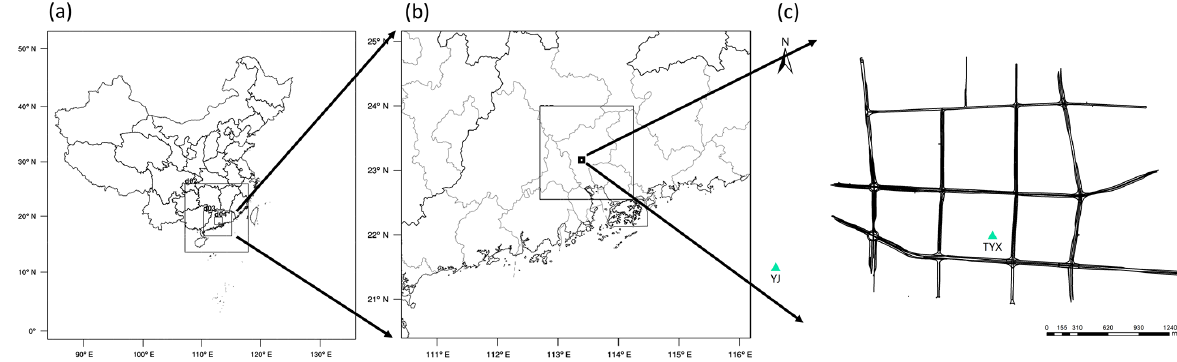
Figure 7. Simulation domain from regional scale to street-level scale: (a) four times nested simulation for WRF; (b) domains 3 and 4 covering the Pearl River Delta region and Guangzhou city, the innermost box corresponds to the Tianhe District; (c) 31 street segments and two observation sites (triangles) within the MUNICH study domain.